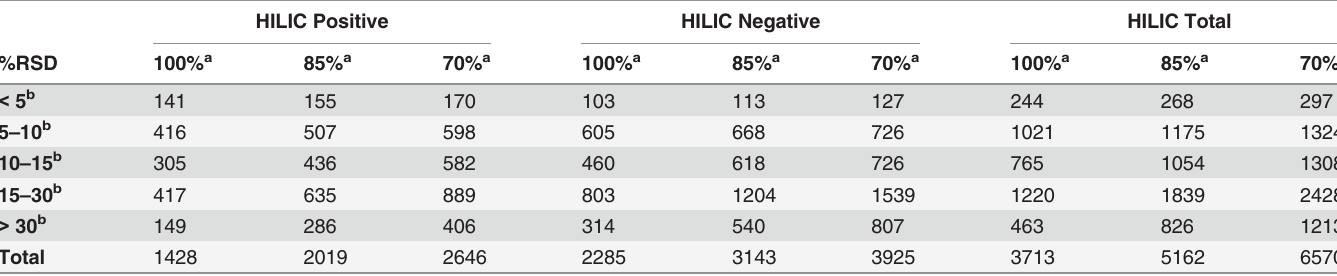
Table 1. Measured metabolite features in the HILIC method in experiment 1.